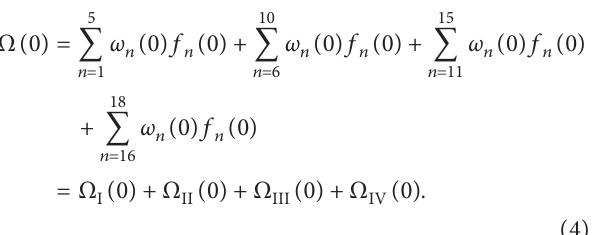
Table 1: Initial condition of violence Ω ( 0 ) by frequency f